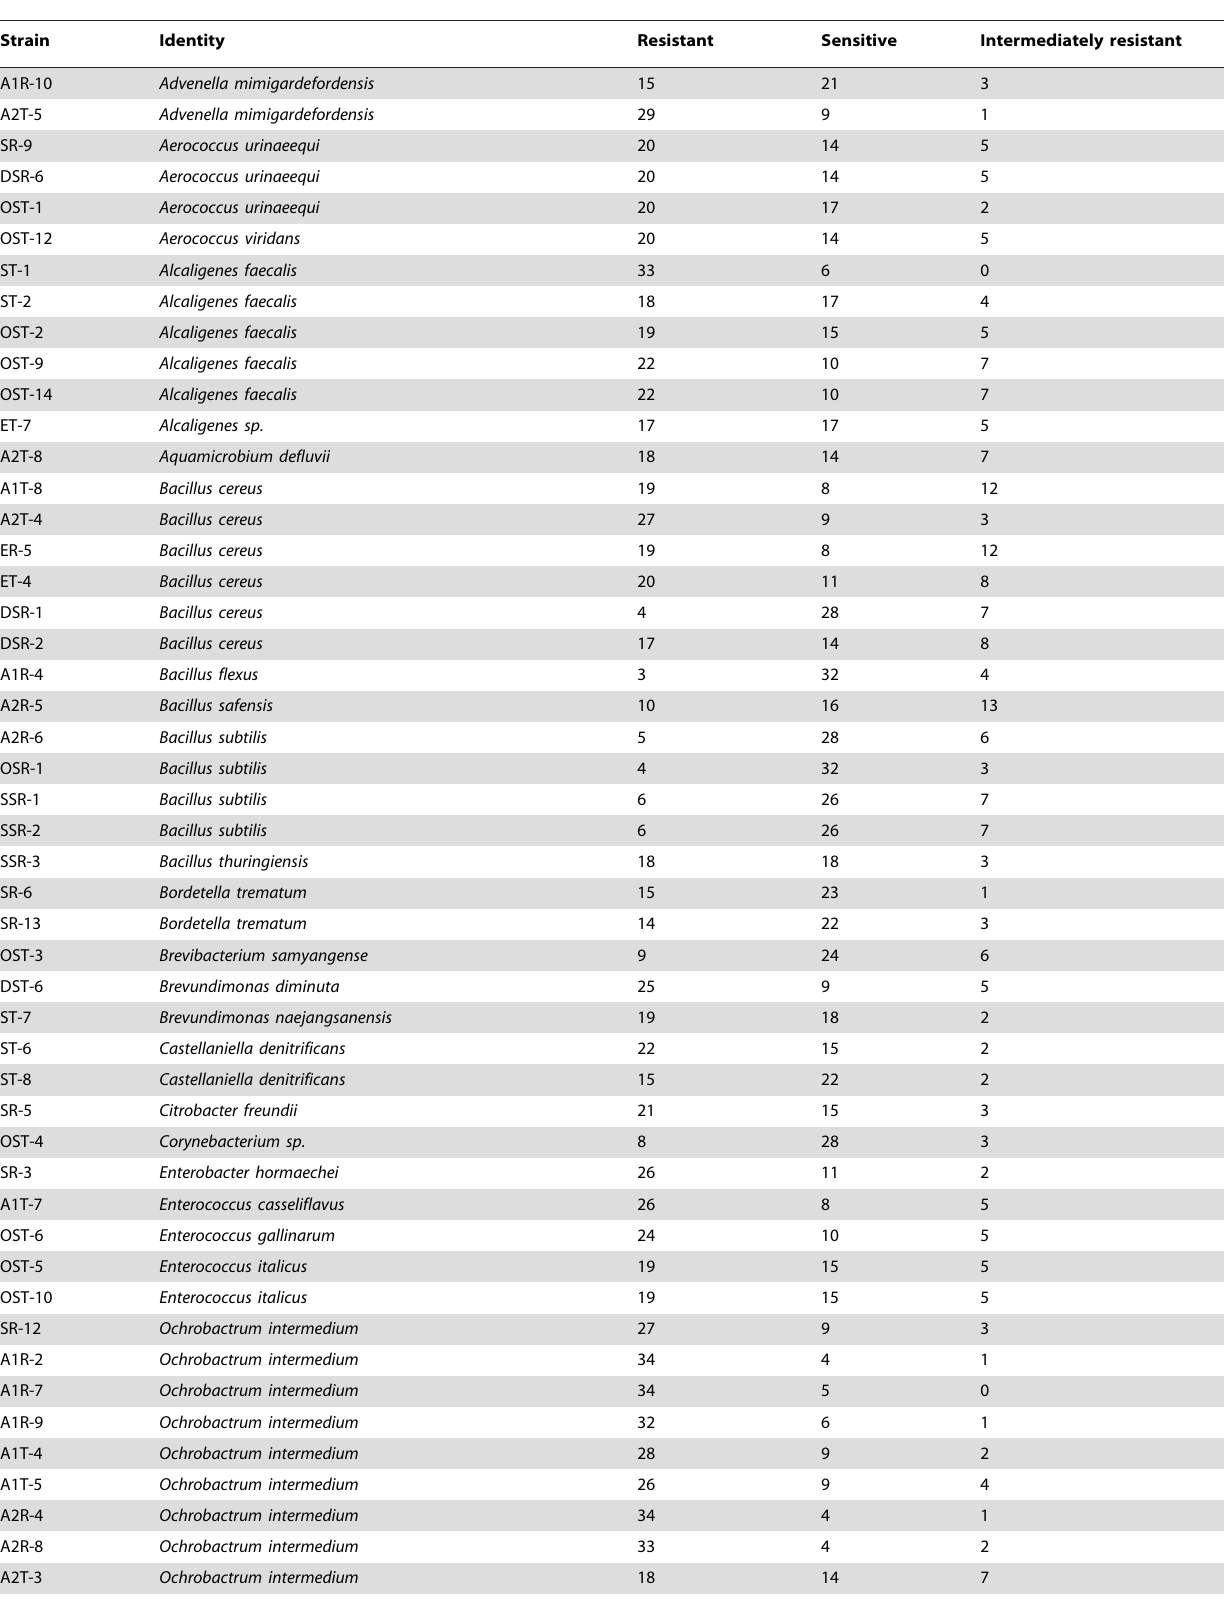
Table 2. Identity and antibiotic sensitivity pattern of the bacterial strains isolated from the PETL WWTP against 39 antibiotics.